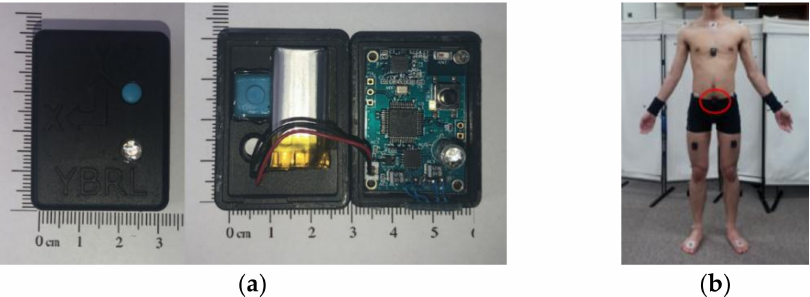
Figure 1. ( a ) Inertial Measurement Unit (IMU) sensor; ( b ) Sensor position.